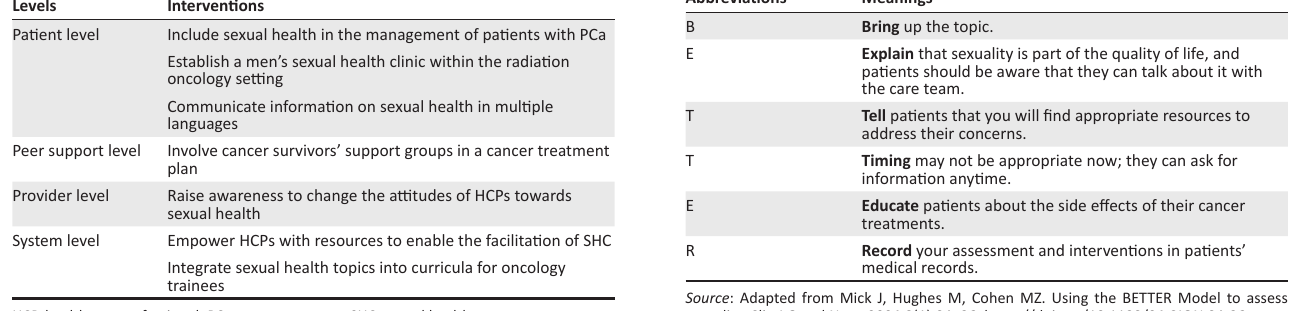
TABLE 2: The BETTER model’s description. TABLE 1: Proposed multilevel interventions to address sexual health gaps.